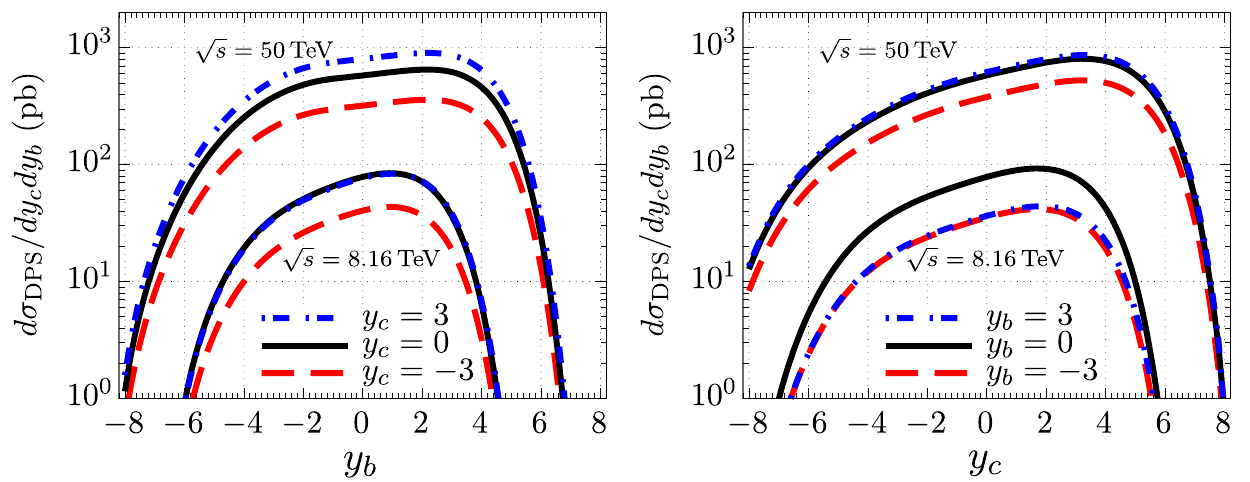
Fig. 5 The DPS c ¯ cb ¯ b production cross section in pA UPCs as a function of c -quark rapidity at fixed b rapidity (left panel) and as a function of b -quark rapidity at fixed c -quark rapidity (right panel)